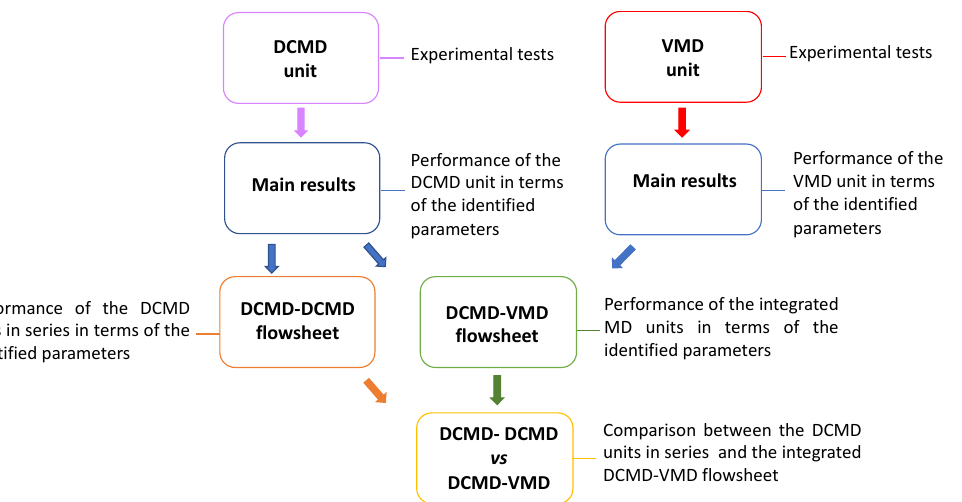
Figure 3. Summary of the steps followed in this work.